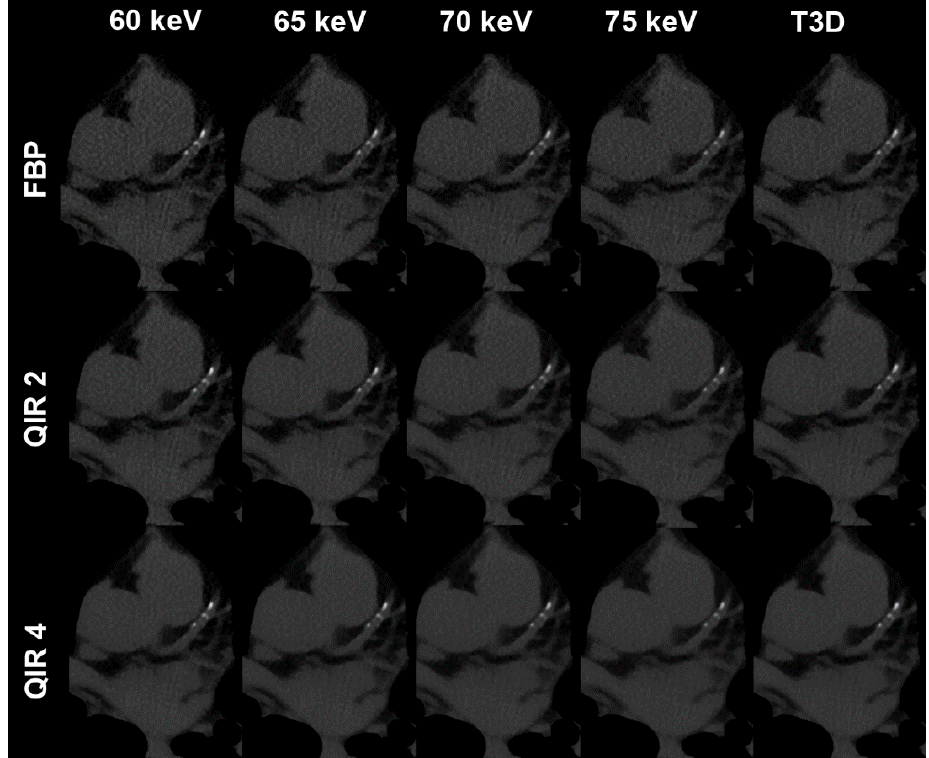
Figure 1. Representative images of a 56-year-old male patient undergoing non-enhanced ECG-gated CT dedicated to coronary calcium scoring. Transverse CT image data sets at the same slice positions reconstructed with 60 keV (far left column), 65 keV (second to left column), 70 keV (middle column), 75 keV (second to right column) and T3D (polychromatic 120 kV reconstruction; far right column); filtered back projection (upper row) and Quantum Iterative Reconstruction at strength levels 2 (middle row) and 4 (bottom row). Coronary calcium scores decrease with increasing keV levels (lowest scores for 75 keV) and with increasing strength of QIR (lowest scores for QIR level 4). T3D reconstructions were similar to 65 keV